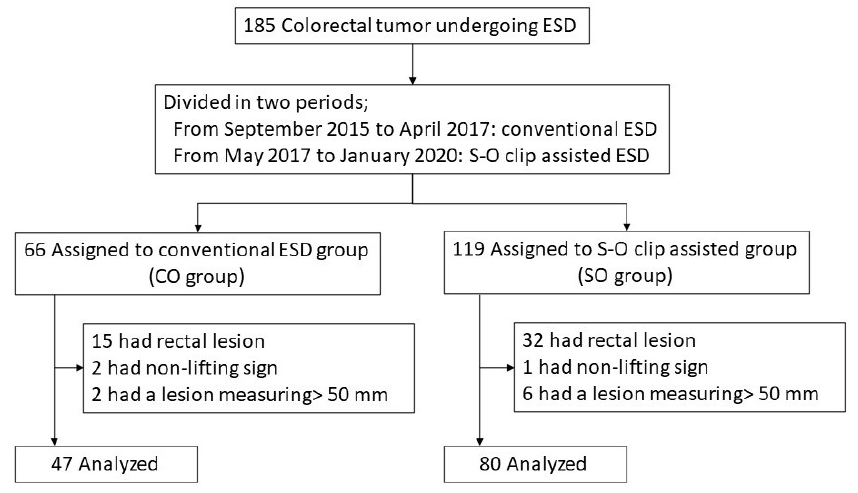
Figure 3. Flow diagram of the study patients.